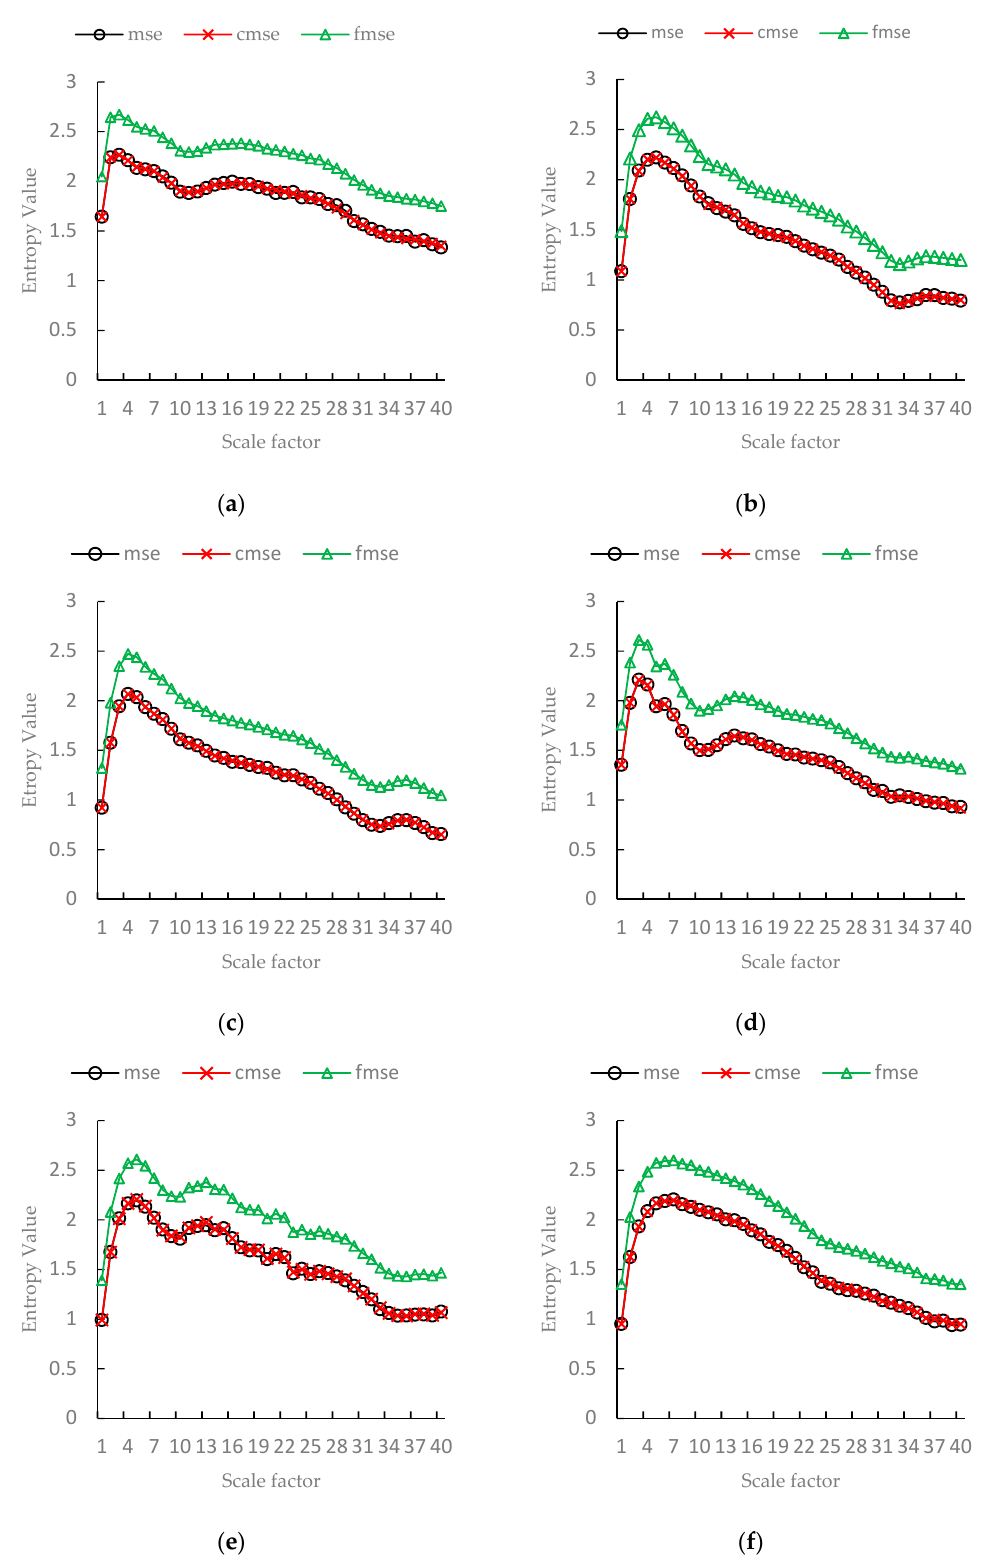
Figure 12. The means of MSE, CMSE, FMSE values on bearing vibration data (1730 rpm, 7 mils). ( a ) Normal state; ( b ) Outer race fault (3 o’clock position); ( c ) Outer race fault (6 o’clock position); ( d ) Outer race fault (12 o’clock position); ( e ) Ball fault; ( f ) Inner race